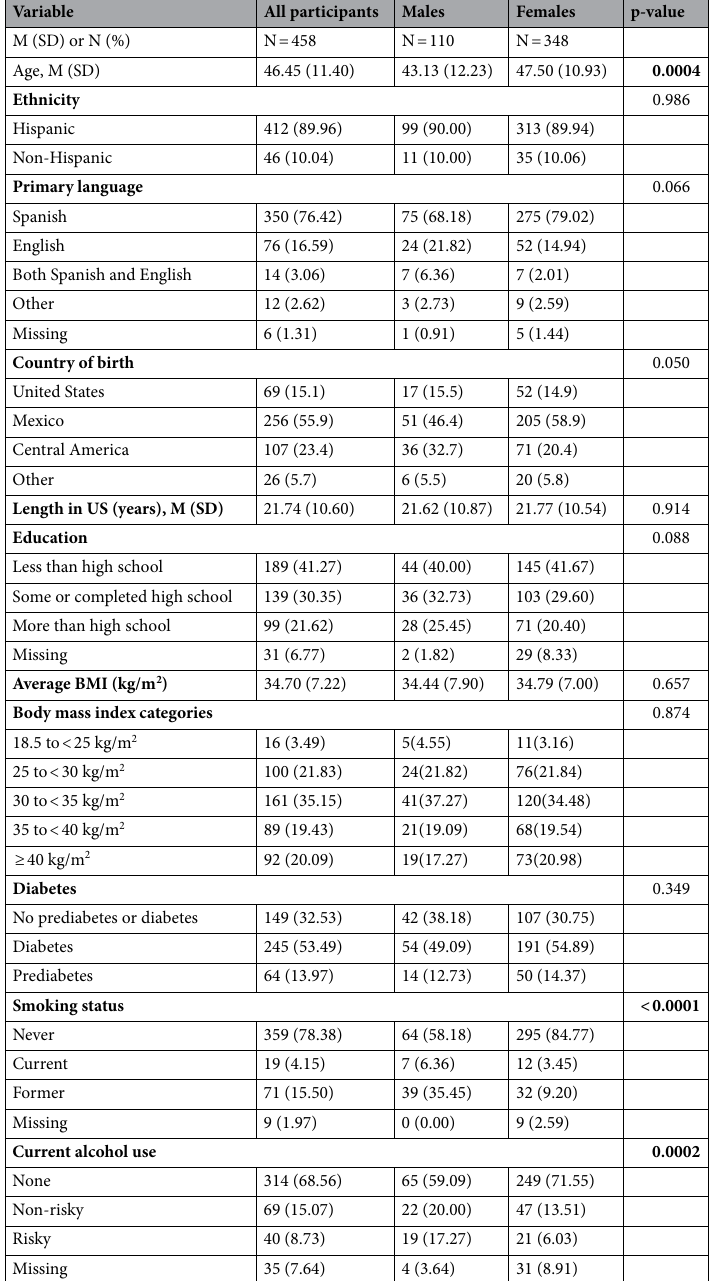
Table 1. Demographic and clinical characteristics at baseline. Significant p values are in bold. M mean, SD standard deviation, yr